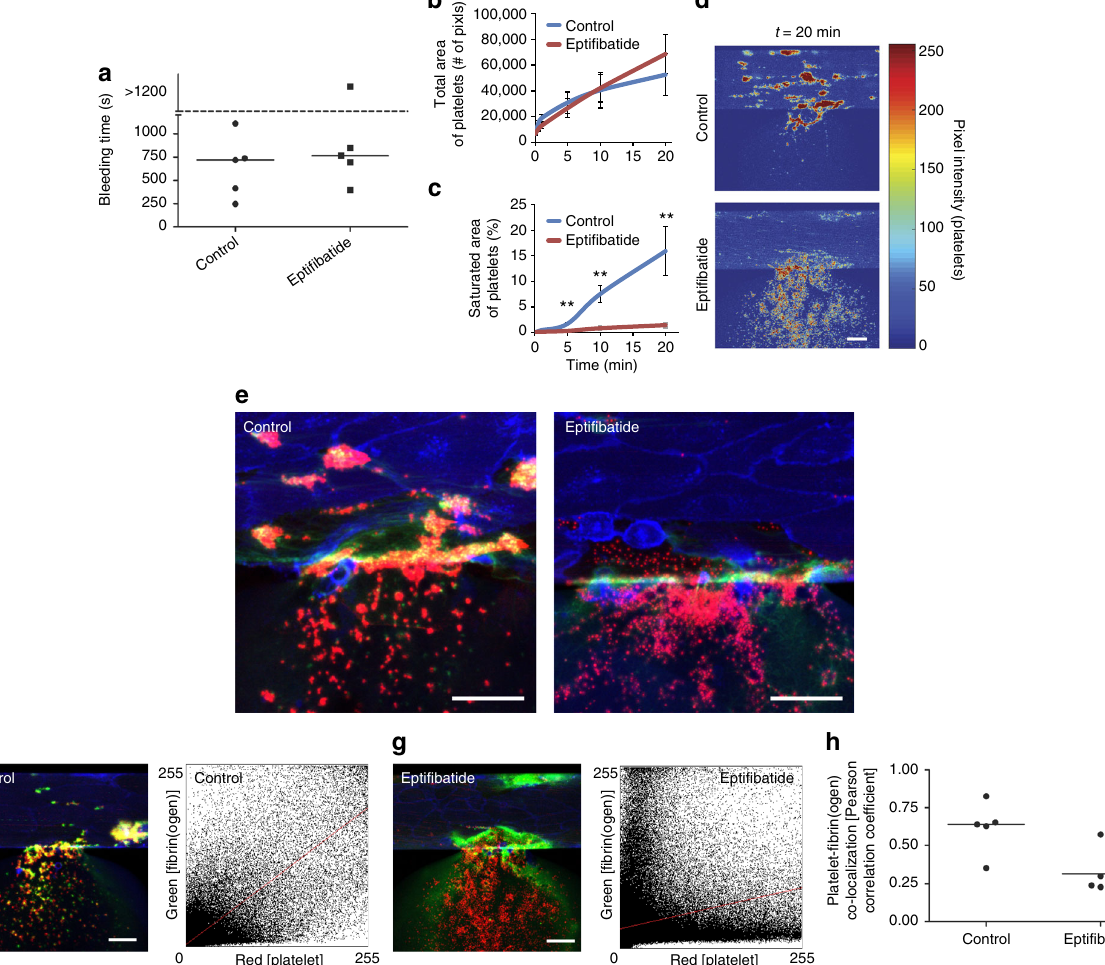
Fig. 2 Integrin α IIb β 3 antagonism alters hemostatic plug architecture by inhibiting platelet – fi brin binding and clot contraction. a Healthy blood treated with 10 µ g ml − 1 epti fi batide, an anti-platelet drug commonly used in the clinical setting, and healthy blood with vehicle control exhibit similar in vitro bleeding times. b Moreover, the total areas of adhered platelets are also similar between the two conditions. c However, when comparing platelet aggregation followed by clot contraction, which is tracked by measuring the areas of saturated intensity of fl uorescently labeled platelets over time, epti fi batide-treated blood exhibited signi fi cantly less platelet aggregation and clot contraction over the time course of hemostasis as compared to vehicle control conditions. The error bars in the graphs show standard errors (control n = 3, epti fi batide n = 4). Double asterisk (**) shows P -value < 0.05 by Student's t -test. d Heat map of adhered platelets shows dense platelet aggregates with saturated fl uorescence intensity formed in vehicle control conditions at 20 min after bleeding (top) while no aggregation or clot contraction observed in epti fi batide-treated blood (bottom). e Under the epti fi batide-treated conditions, platelet – fi brin binding (as de fi ned by co-localization of platelets — red — and fi brinogen/ fi brin — green) was markedly decreased compared to that of the control conditions. f , g The analyzed images of a representative experiment with healthy control and epti fi batide-treated blood samples (left) and the corresponding platelet- fi brin(ogen) co-localization plot (right). Each co-localization plot displays the pixel intensity of the red channel ( x axis), corresponding to platelets, plotted against the pixel intensity of the green channel ( y axis), corresponding to fi brin(ogen), of each pixel in the respective image. The red lines show the Pearson correlation coef fi cient lines. h Comparing Pearson correlation coef fi cients between healthy control and epti fi batide- treated samples ( n = 5 for each condition) reveals that co-localization is more pronounced in the control condition (Student's t -test, P = 0.008). All scale bars = 50 µ m. Bars in graph represent median